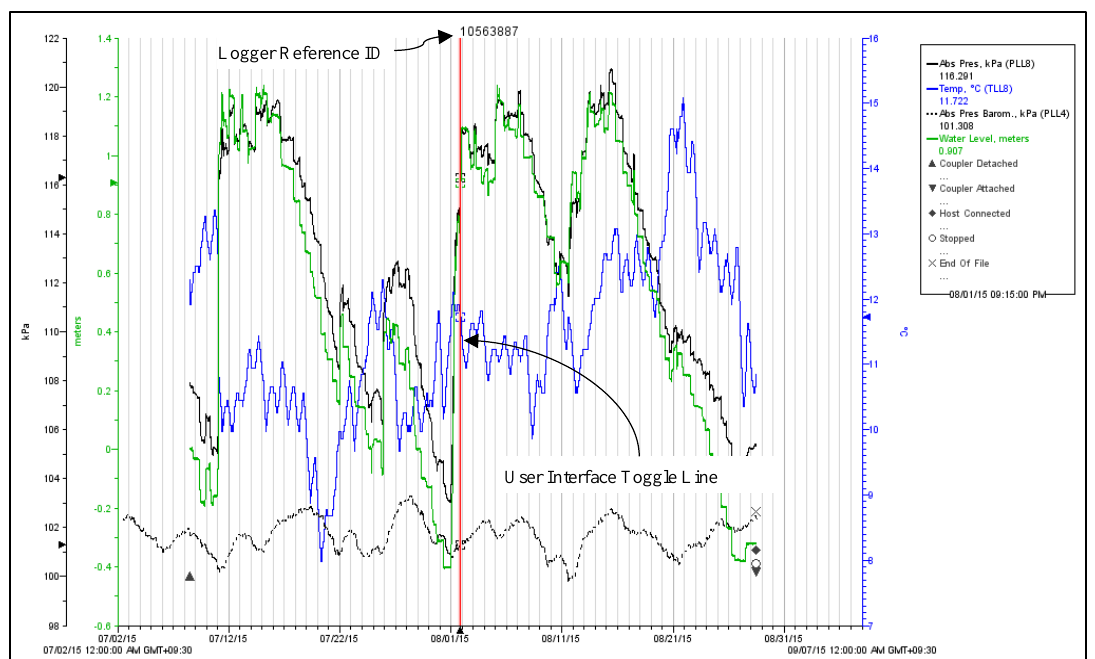
Figure 3. Water level variation within RRH4 during rainfall events.